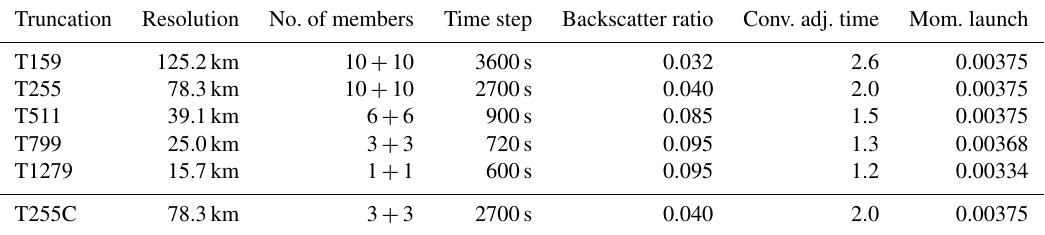
Table 1. Resolution-dependent scientific configuration for EC-Earth in the Climate SPHINX experiments. The same number of ensemble members has been run for present-day AMIP (PDA) and future scenario AMIP (FSA) experiments. T255C is the coupled configuration used for past-to-future coupled (PFC) simulations. Resolution is estimated at the Equator. The number of members indicate the deterministic and stochastic members. Backscatter ratio (tuning parameter for SKEB stochastic scheme), convective adjustment time (tuning parameter for deep convection) and momentum launch (tuning parameter for non-orographic gravity waves) are unitless. Truncation Resolution No. of members Time step Backscatter ratio Conv. adj. time Mom.